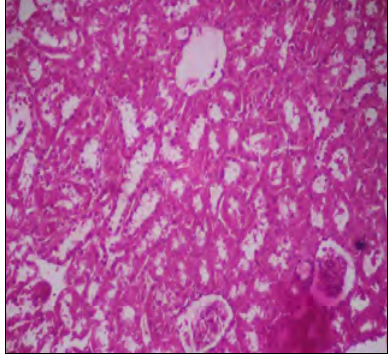
Figure-2. Photomicrograph of kidney showing severe changes in tubules with dilation and severe fatty change and reduced glomerular space. H&E X200 (Group 4)